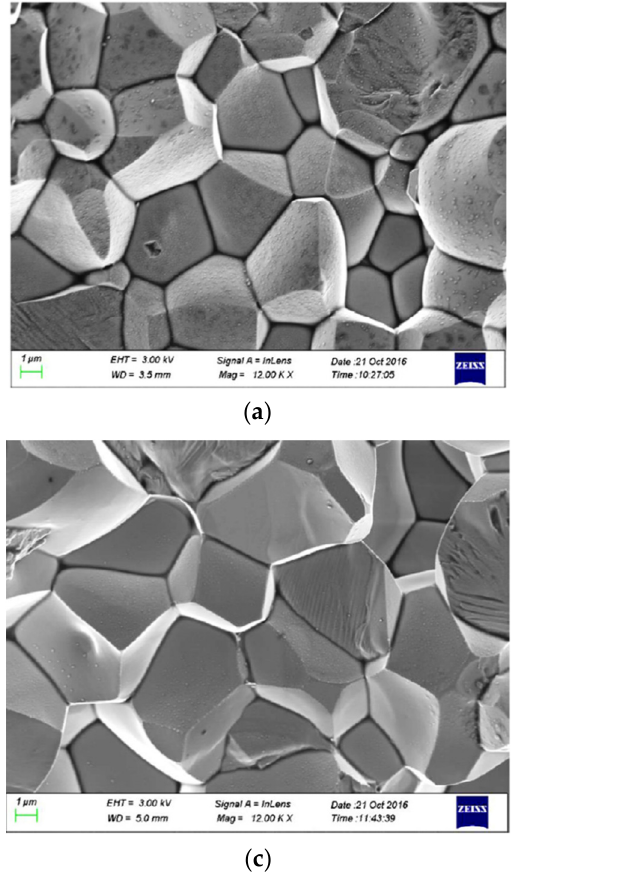
Table 3. Summary of electro-optical transparent nano-ceramics described in the text grouped by publication year.